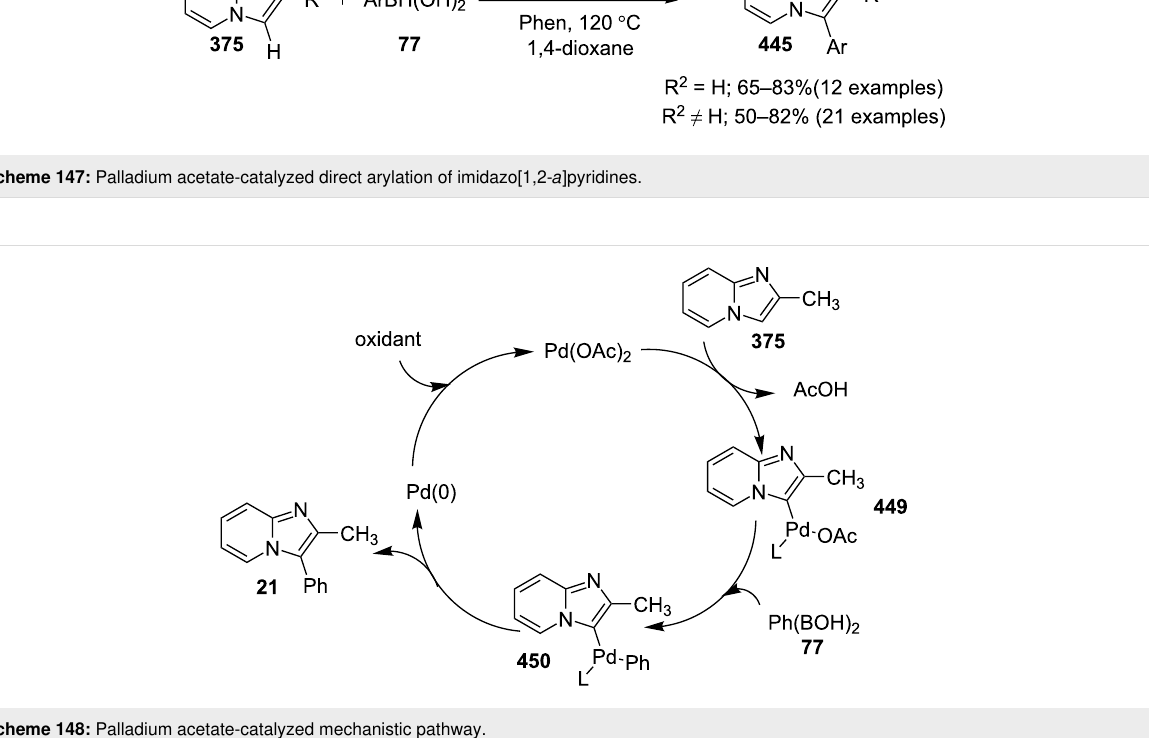
Scheme 148: Palladium acetate-catalyzed mechanistic pathway.